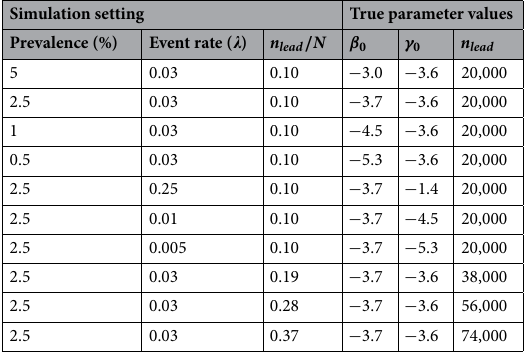
Table 1. Simulation settings varying baseline outcome prevalence β 0 , baseline event rate γ 0 , and size of lead site n lead